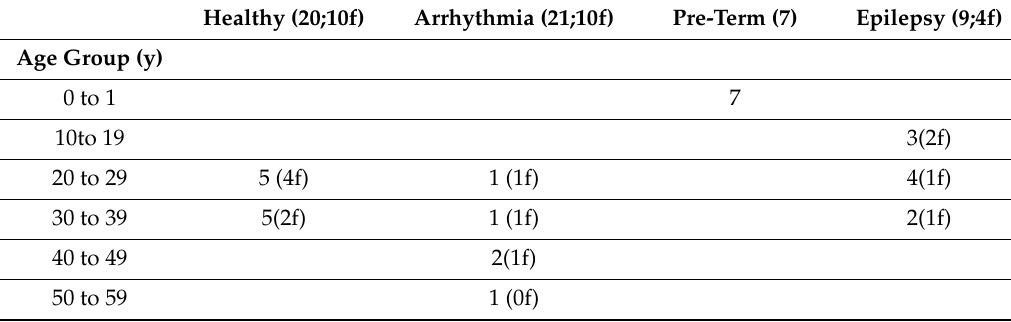
Table 2. Age and gender distribution of the participants in the BisQ comparisons study. The number of female participants is indicated in brackets (e.g., four female participants in the 70 to 79 years of age group of healthy persons). No gender data were provided for pre-term